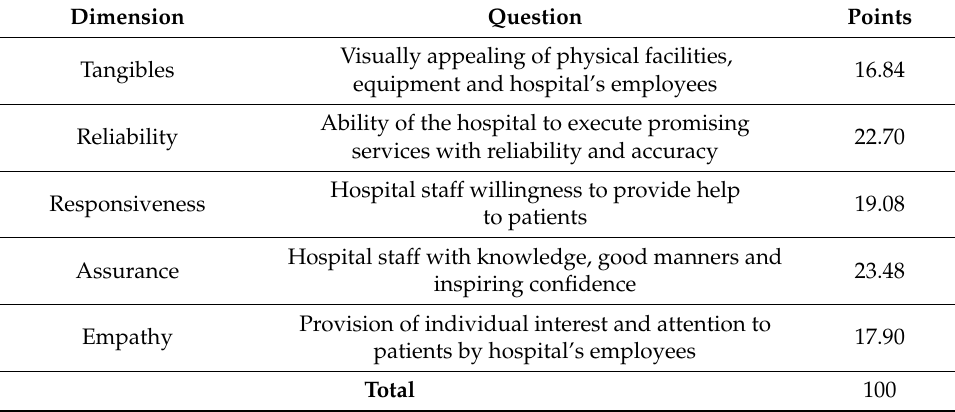
Table 8. Prioritization of quality